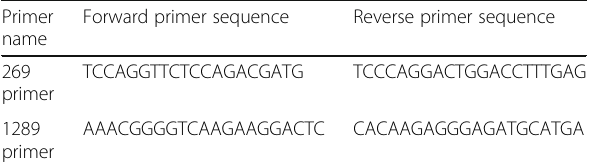
Table 2 Primer sequence for SLC22A12